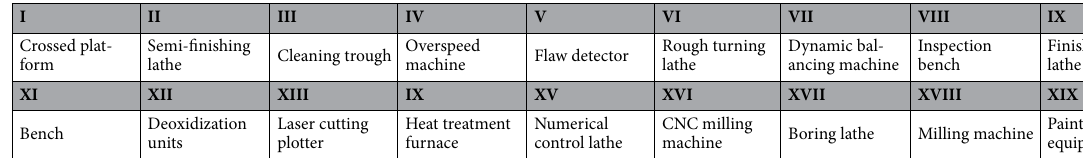
Table 1. Comparison of workshop production equipment